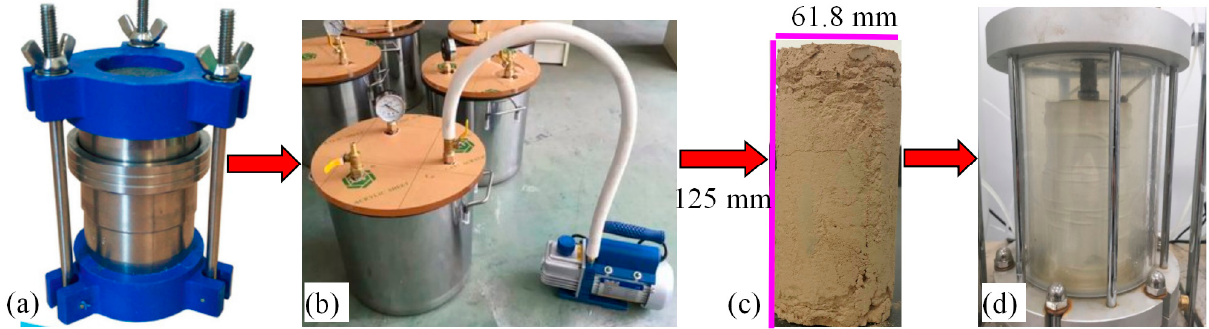
Figure 3. Specimen with the dry-wet cycles. ( a ) Frame saturator chamber, ( b ) vacuum container, ( c ) specimen after dry-wet cycles, ( d ) triaxial chamber. ( c ) specimen after dry-wet cycles, ( d ) triaxial Table 1. The physical index properties of loess.